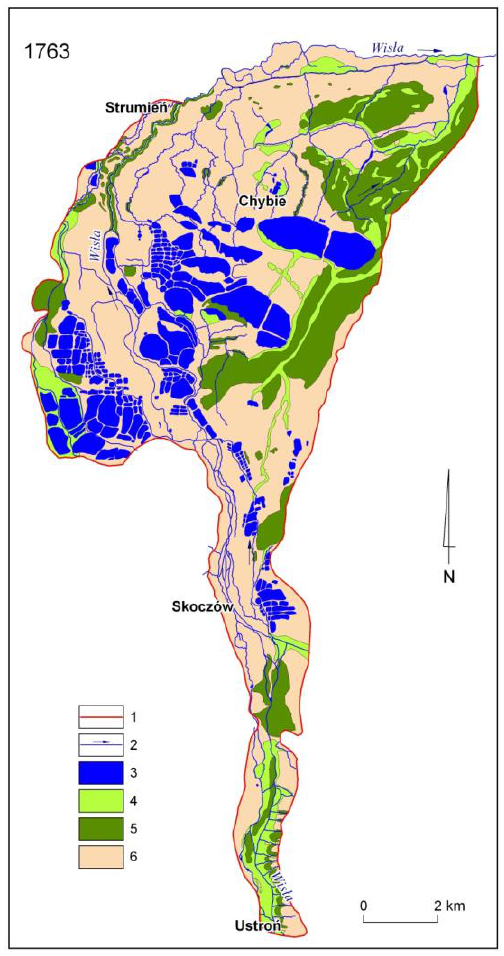
Fig. 2. Types of land use in the River Vistula alluvial fan area Fig. 3. Types of land use in the RiverVistula alluvial fan area in the mid-18 th century in the mid-19 th century (according to Ubersicht der Militar … 1839-1840) 1 - border of the research area, 2 - river network, 3 - water reservoirs, 4 - meadows and pastures, 5 - forests and shelters, 6 - agricultural land and dispersed